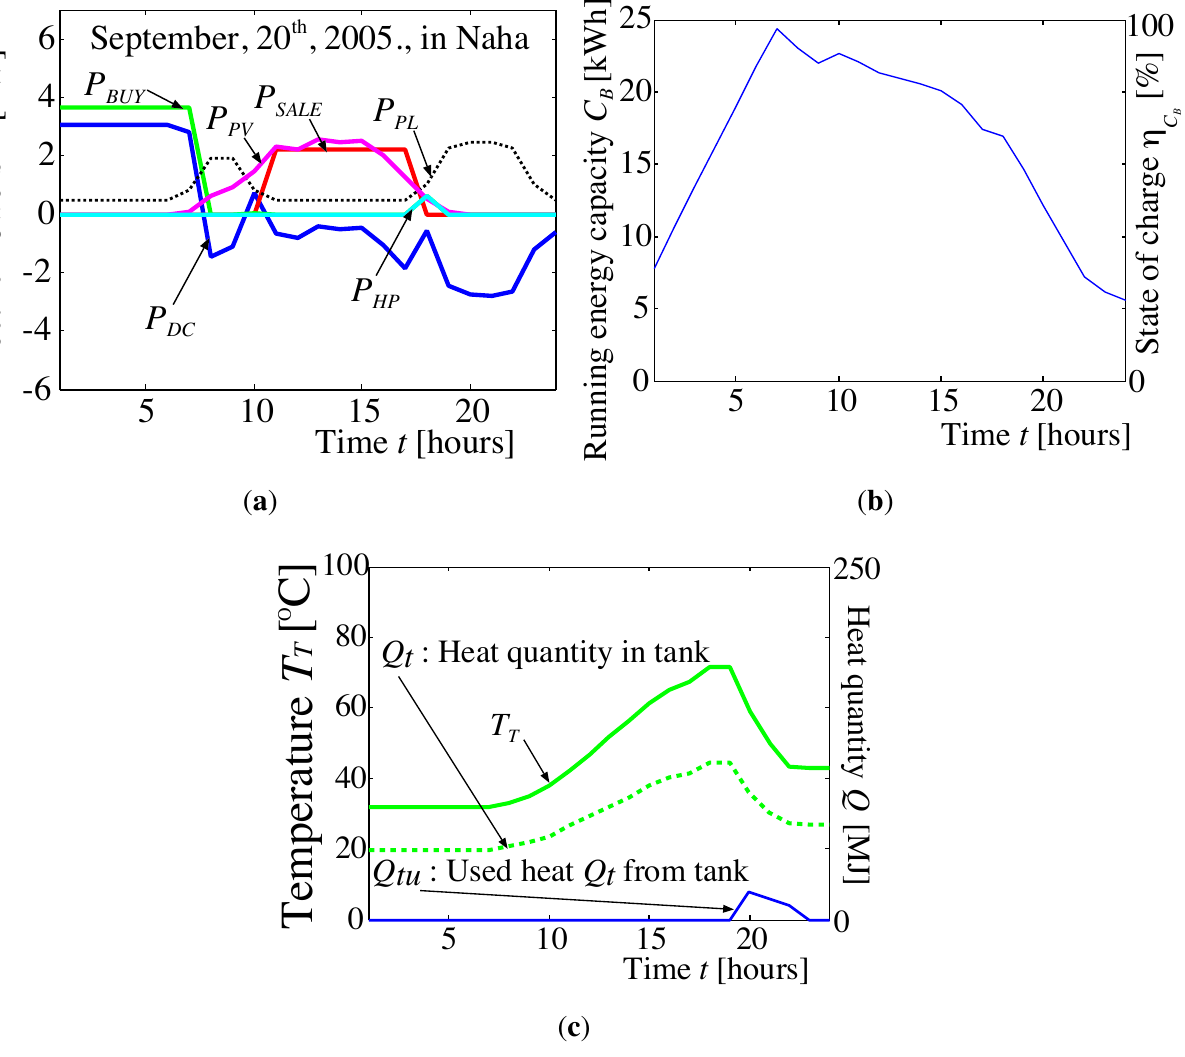
Figure 4. Simulation results (sunny day, case 1: no forecast errors). ( a ) Optimized result; ( b ) Battery; ( c ) Temperature of tank and used heat